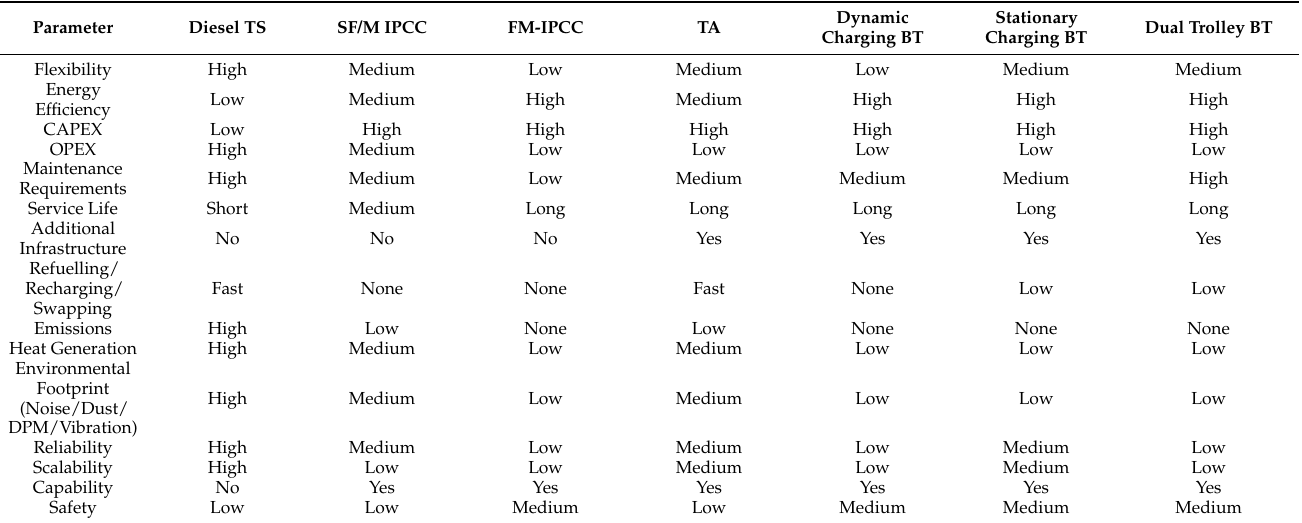
Table 2. Comparison between diesel TS, IPCC, TA and